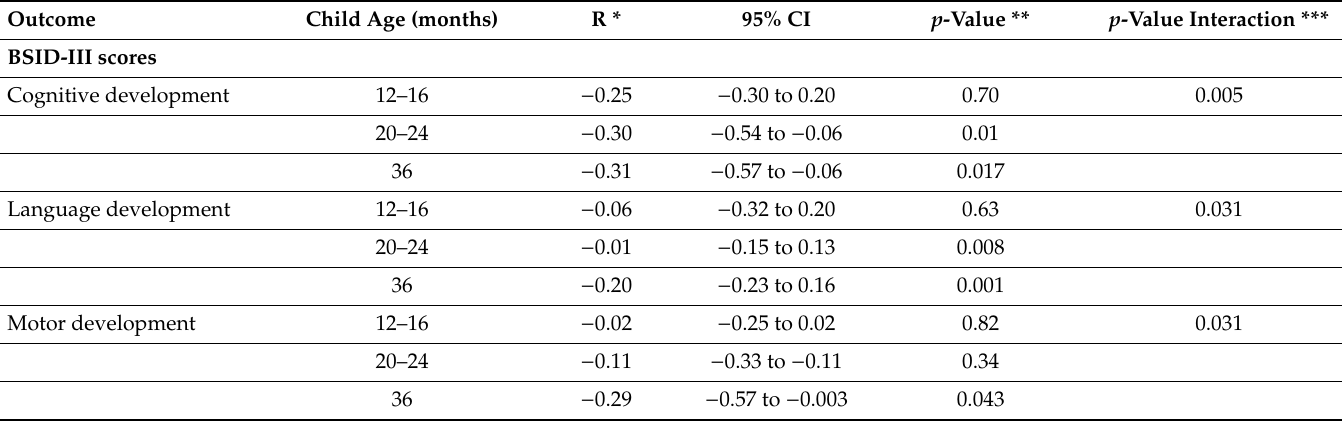
Table 3. Associations between maternal depression (BDI-II scores) and BSID-III child developmental scores for the whole study